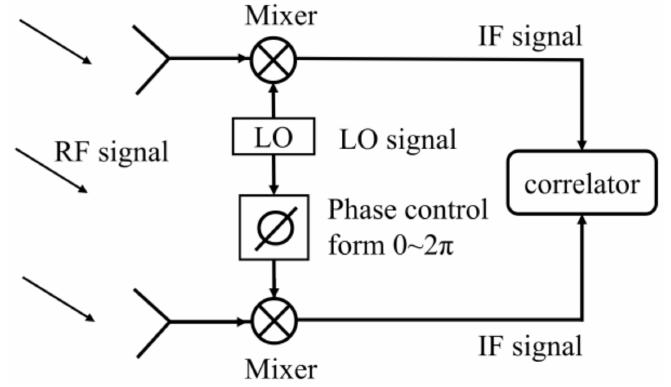
Figure 1. A simple block diagram of the interferometric imaging